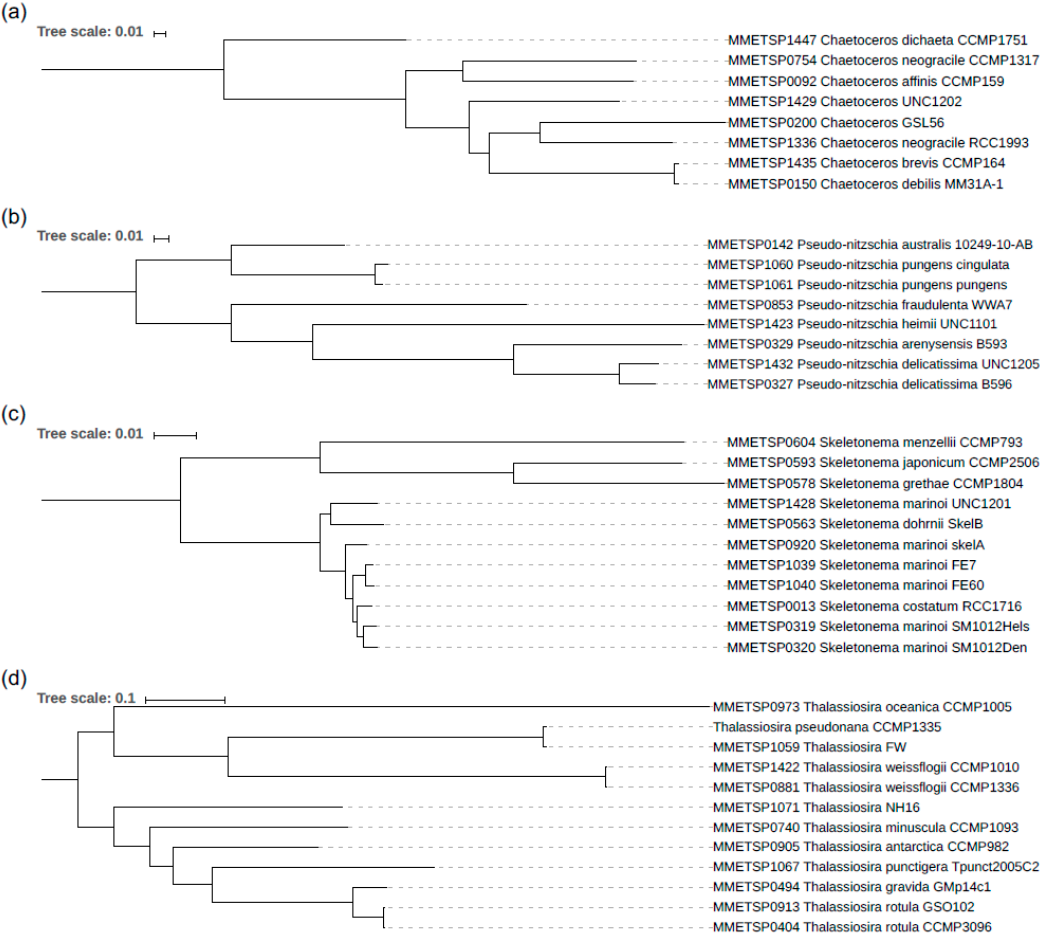
Figure2. Phylogeniesof Chaetoceros ( a ); Pseudo-nitzschia ( b ); Skeletonema ( c ); and Thalassiosira ( d Figure 2. Phylogenies of Chaetoceros ( a ); Pseudo ‐ nitzschia ( b ); Skeletonema ( c ); and Thalassiosira ( d ) obtained by RaxML from the single orthologs identified by Orthofinder. DensiTree plots for these genera are shown in Figure S3.